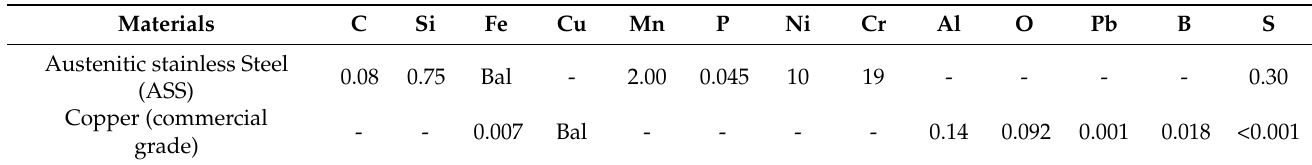
Table 1. Base metals chemical composition.